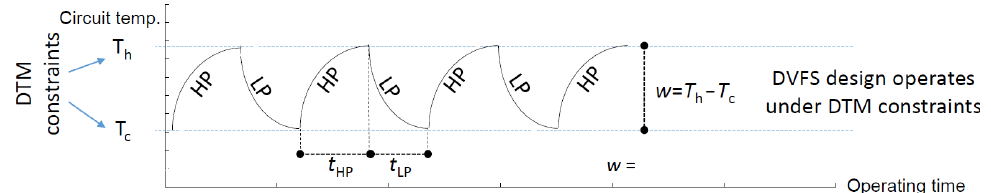
Figure 9. DVFS design operating under DTM